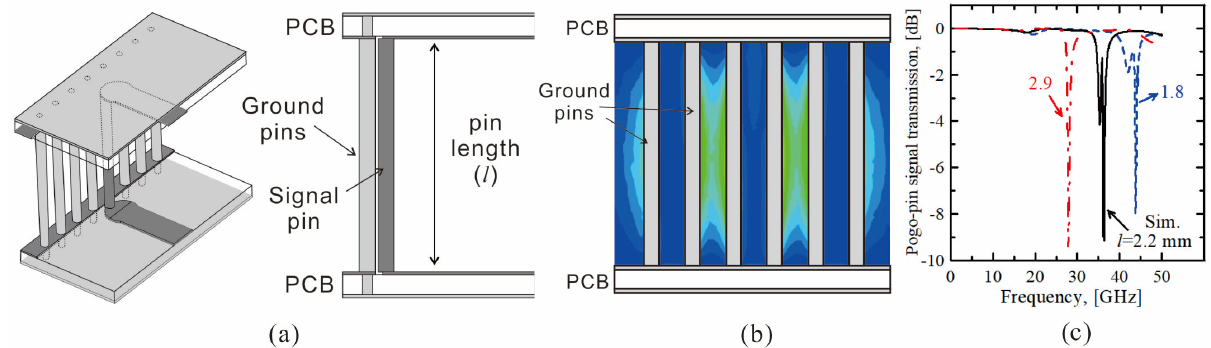
Figure 7. ( a ) Simplified Pogo-pin structure for HFSS analysis, ( b ) HFSS E-field plot at the resonance, and ( c ) simulated resonant frequency shifts for varying pin